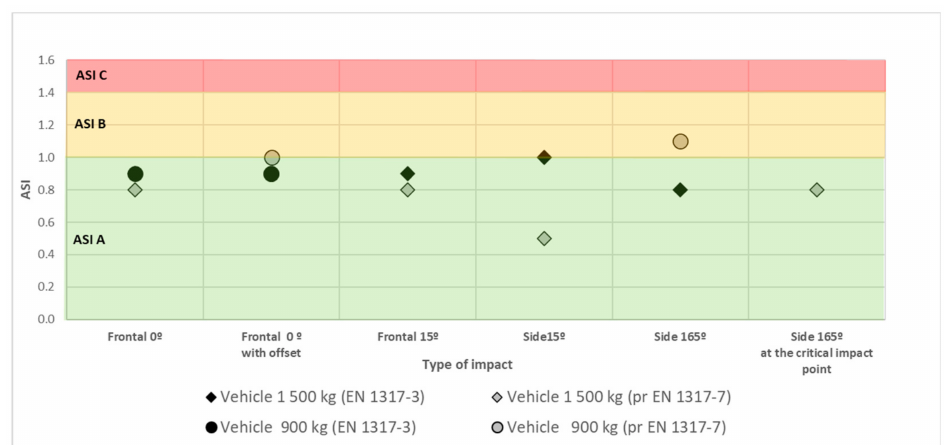
Figure 13. Results of ASI tests from SE field crash